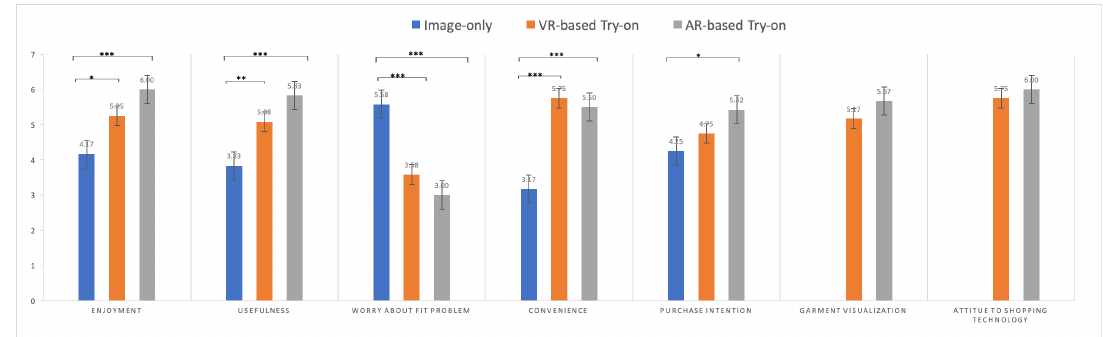
Figure 9. Perceived levels of enjoyment, usefulness, worry about fit problem, convenience, purchase intention, garment visualization, and attitude to shopping technology. Note: * p < 0.05, ** p < 0.01, *** p <